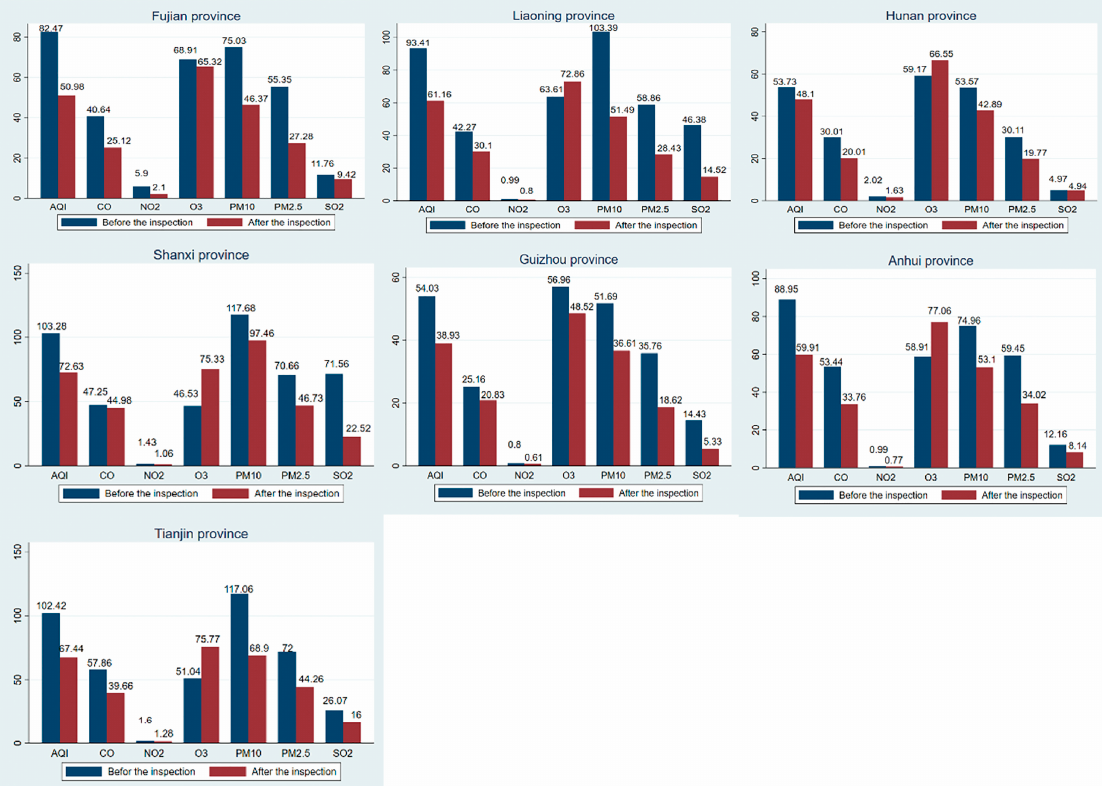
Figure 3. Air quality difference map before and after inspections.